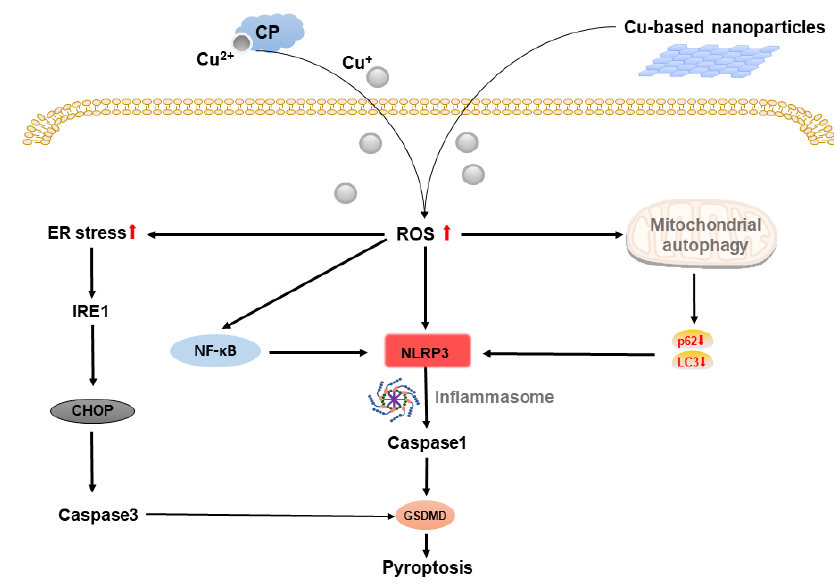
Figure 4. Schematic representation of copper-based pyroptosis. Cu-induced ROS upregulates NLRP3 and inflammatory factors(IL- Iβ and IL -18), which activates Caspase1-dependent pyroptosis via activation of GSDMD. Cu-induced ROS also activates NF-kB pathway and mitochondrial autophagy (decreases LC3 and p62) that induces pyroptosis via NLRP3/caspase1/GSDMD axis. In the meanwhile, Cu en- hanced ER stress activates caspase3-dependent pyroptosis. 2.5. Copper-Based Paraptosis Paraptosis is a kind of PCD characterized by mitochondria an/or ER dilation, and cytoplasmic vacuolization via caspase-independent pathway that is different from apop- tosis [47]. Paraptosis could be induced by ER stress as a result of DNA damage signal pathway [48]. As apoptosis resistance is intimately associated with tumorigenesis, parap- tosis, as a substantial way following failure of apoptosis, could contribute to tumor cell death [49 – 51] Several studies have indicated that copper-based complexes can induce paraptosis in human cancer cells by inhibiting ubiquitin-proteasome system, involving ER stress and UPR activation. In an early investigation on cisplatin-resistant cancer cells, Marzono’s group found that cells treated with a copper-based complex did not show caspase-3 activation (classic executor enzyme of apoptosis), indicating a potential relation to trigger paraptosis [52]. Afterwards, they suggested that lysosome damage was an early cellular process of copper-based complex to overcome cisplatin-resistant cancer cells, whereas phosphine copper could suppress the growth of cancer cells via G2/M cell cycle and paraptosis, probably by boosting ROS [53]. Furthermore, the copper complex induced paraptosis in a wide panel of human cancer cell lines by upregulating UPR related genes, resulting in eIF2α phosphorylation, an increase in XBP1 mRNA, as well as overexpression of ATF4, CHOP, BIP and GADD34 [54]. The copper-based complex also exhibited tumor cells selectivity VS normal cells, and inhibited 26S proteasome activity, which could in- duce polyubiquitination and suppression of the ubiquitin – proteasome pathway, leading to ER stress [55,56]. Chen’s findings also supported the ubiquitin– proteasome-associated paraptosis, which depends on ATF4-based ER stress but is unrelated to ROS generation [57]. In a study of therapeutic resistance cancer cells, Chen et al. developed a DSF/copper complex copper diethyldithiocarbamate (Cu(DDC) 2 ), inducing cell death in drug-resistant prostate cancer cells through paraptosis [58]. In general, copper-based complexes can